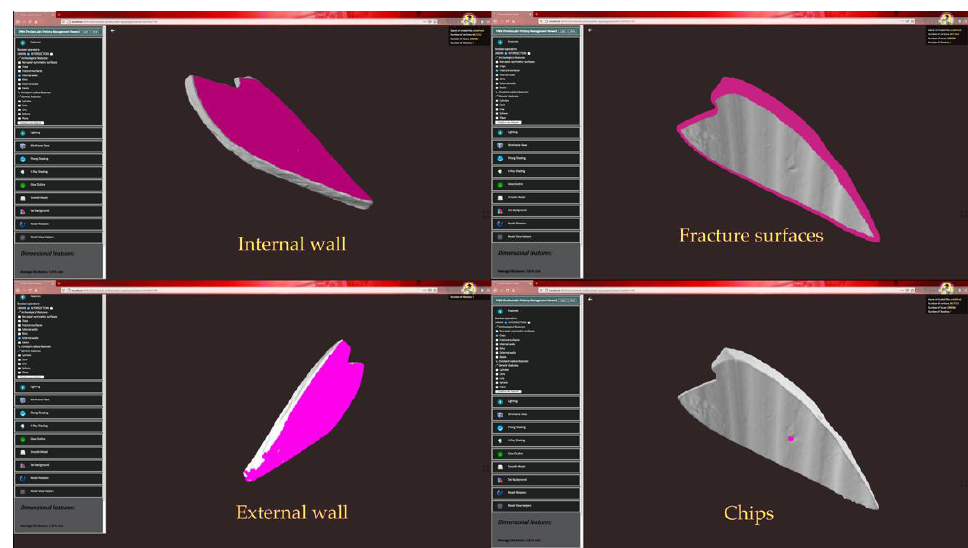
Figure 7. Four screenshots of the application and some recognized features in a type-A sherd. Table 2. Categories of ceramic features deriving from the sherd surface